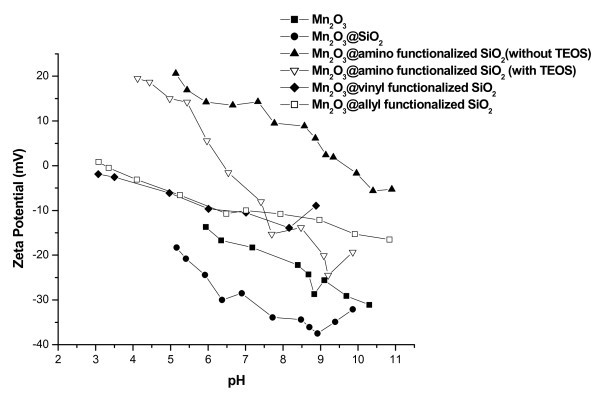
Zeta potential vs. pH plot. Zeta potential versus pH plot for bare Mn2O3, Mn2O3@SiO2, Mn2O3@amino-functionalized silica (with TEOS), Mn2O3@amino-functionalized silica (without TEOS), Mn2O3@vinyl-functionalized silica, and Mn2O3@allyl-functionalized silica core-shell nanostructures.